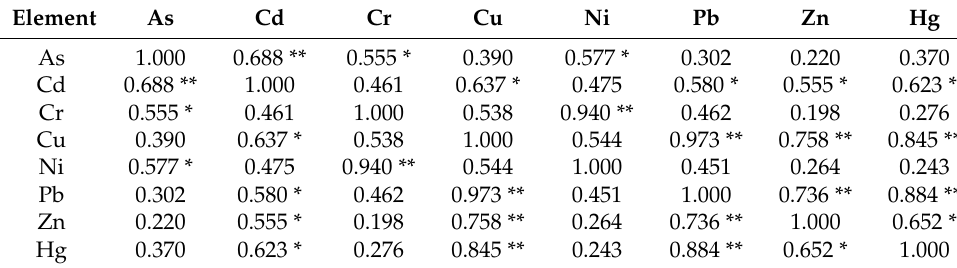
Table 2. Correlation coefficient matrix of the HM concentrations in the topsoil.